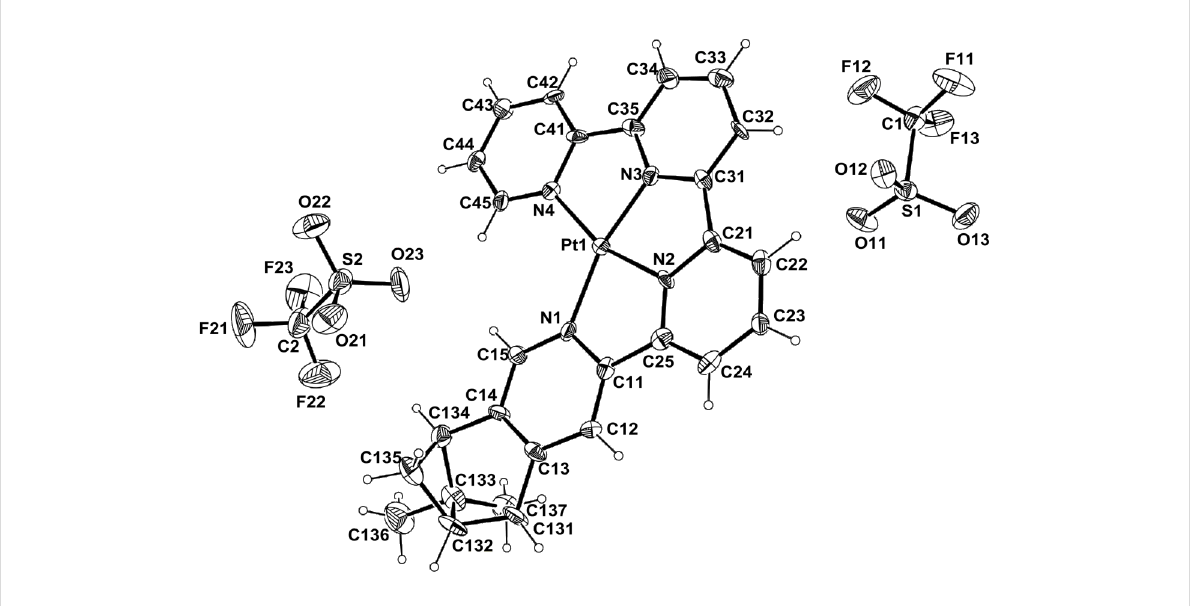
Figure 2: Molecular view of compound 9 using the atom labelling scheme. Selected values of bonds (Å) and angles (°) are given: Pt(1)-N(1): 2.046(6); Pt(1)-N(2): 1.936(7); Pt(1)-N(3): 1.934(6); Pt(1)-N(4):2.052(6); N(3)-Pt(1)-N(2): 82.2(3); N(3)-Pt(1)-N(4):80.3(3); N(3)-Pt(1)-N(1): 162.9(3); N(2)-Pt(1)-N(4):162.4(3); N(2)-Pt(1)-N(1): 80.8(3); N(1)-Pt(1)-N(4): 116.8(3). Ellipsoids are drawn at the 50% probability level. H atoms are repre- sented as small circle of arbitrary